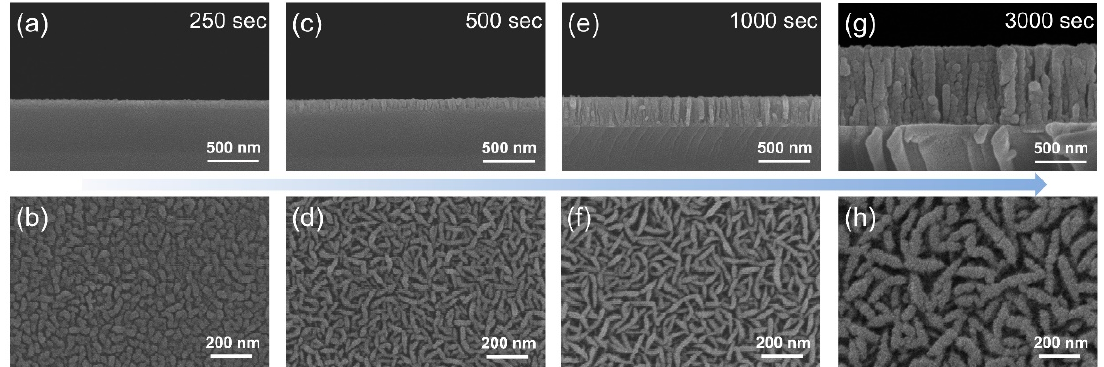
Figure 2. SEM images of step-by-step nanowall growth. Four different sputtering deposition times, ( a , b ) 250 s ( c , d ) 500 s ( e , f ) 1000 s, and ( g , h ) 3000 s, show sequential growth of nanowalls from islands to thicker and taller nanowalls. ( a , c , e , g ) are cross section images and ( b , d , f , h ) are top-view images.